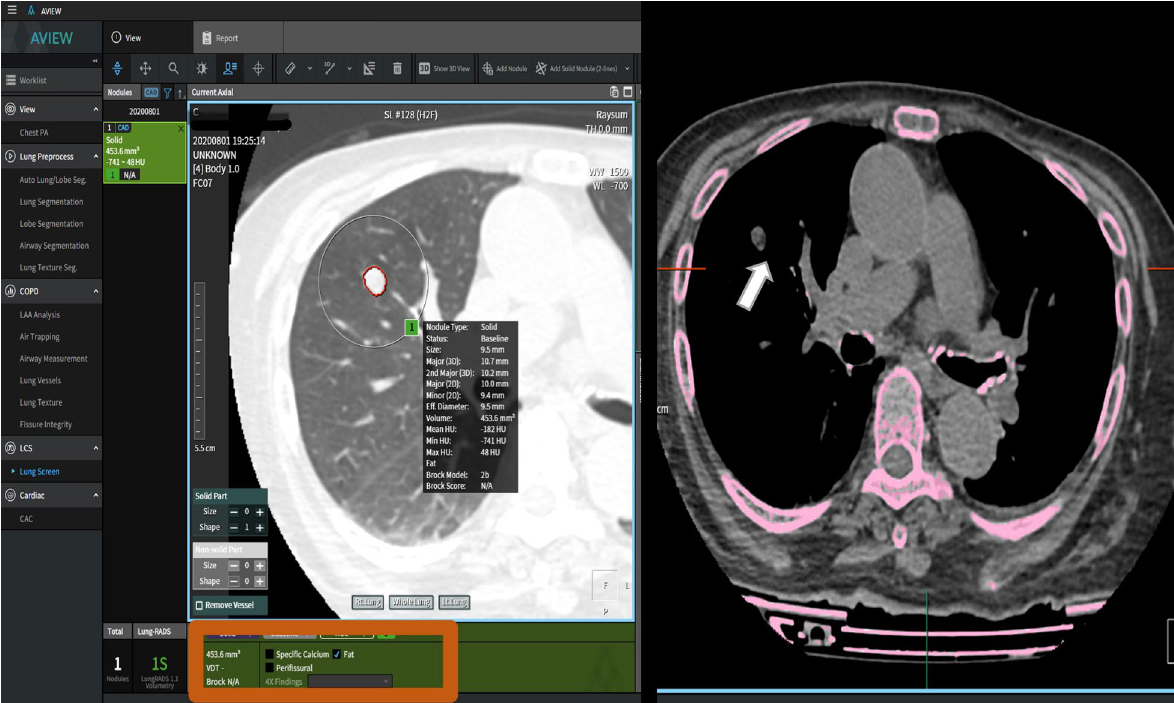
Fig. 4 Final CAD system categorization of the solid nodule into Lung‑RADS 2 after adding the fat as special feature of the nodule (Right: lung window, Left: mediastinum